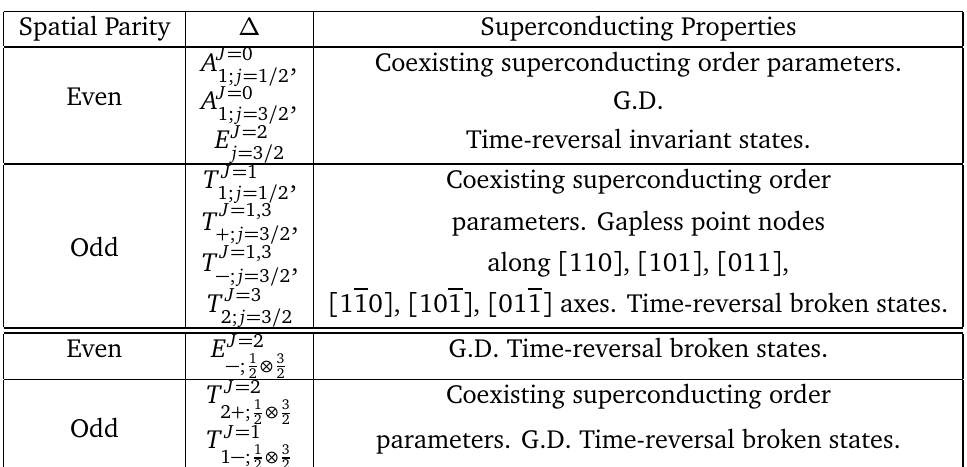
Table 2: Non-vanishing superconducting states resulting from electron-electron in- teractions induced by novel Kondo coupling. G.D. = Gapped dispersion with acquired k dependence from pairing potential. The corresponding order parameters are pro- vided in Figs. 2,